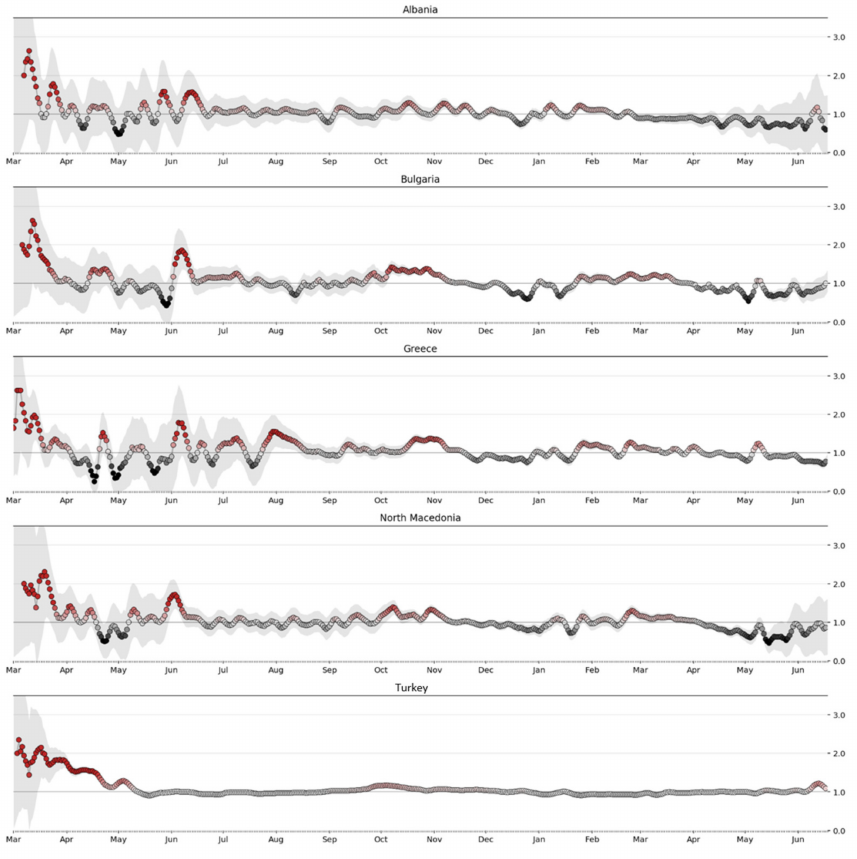
Figure 22. Real-time R t for Greece and surrounding